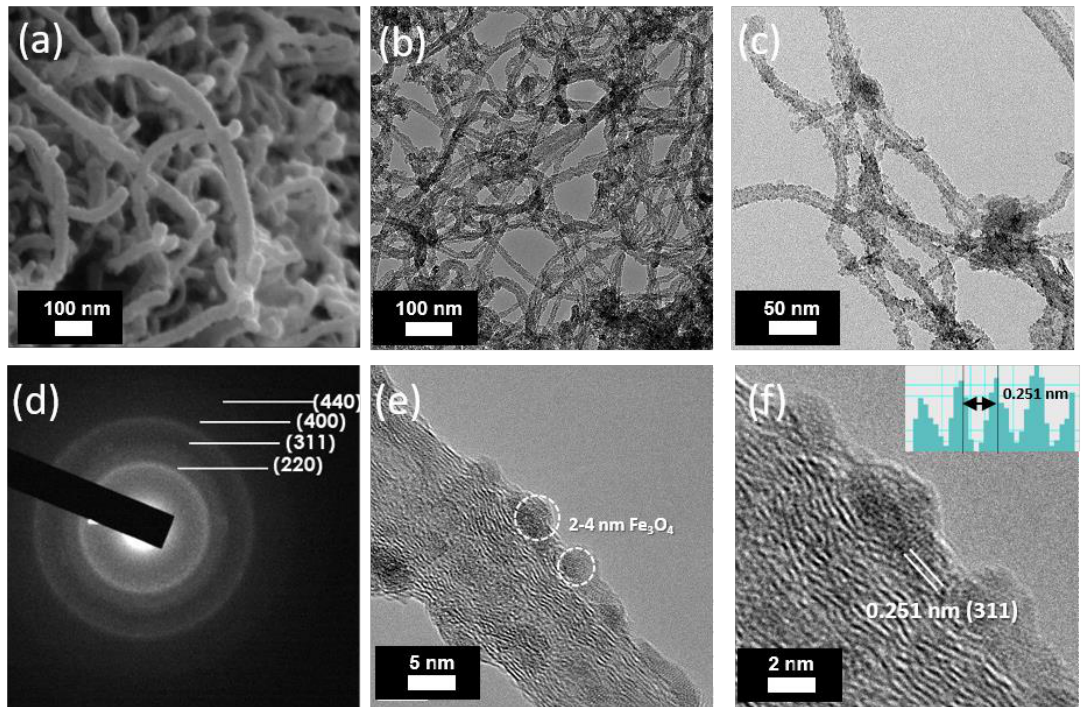
Figure 2. ( a ) SEM image ( b , c ) TEM images. ( d ) Selected area electron diffraction pattern or SAED pattern, ( e , f ) FE-TEM images of nano-Fe 3 O 4 /CNT composite.